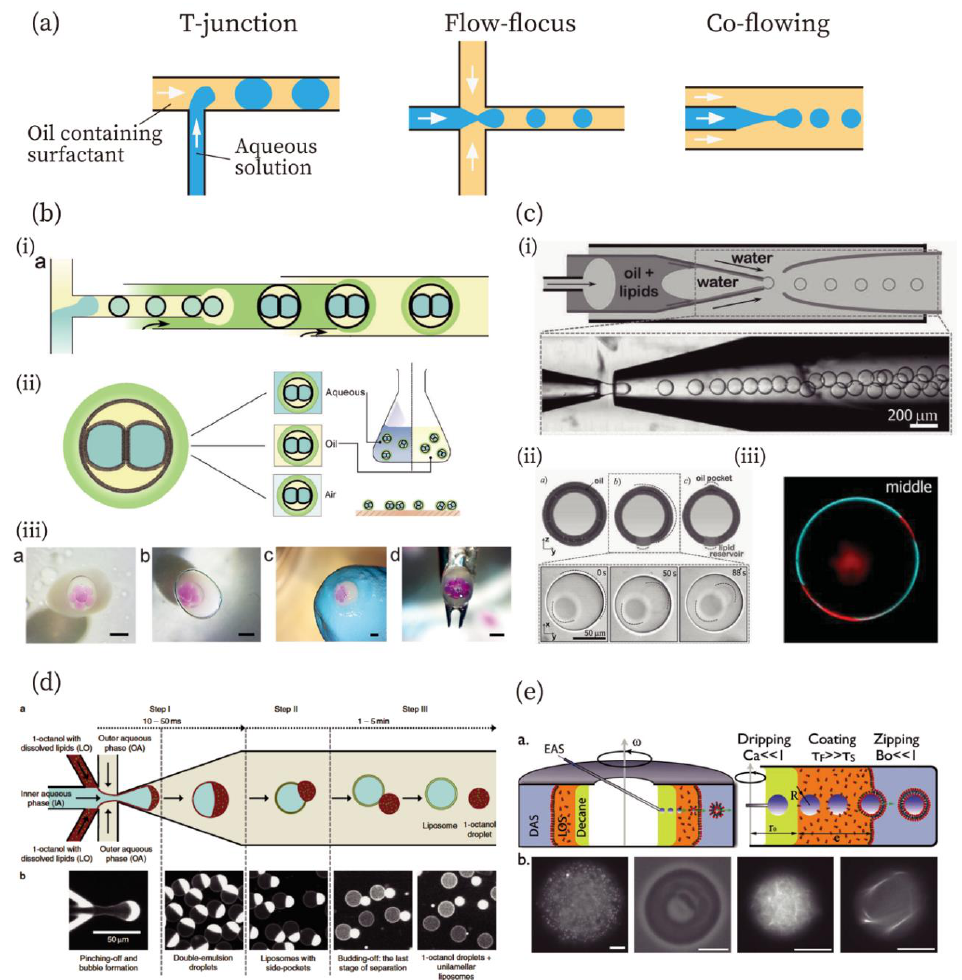
Figure 1. Methods for the production of compartments for artificial cells. ( a ) Typical design of flow channels for the fabrication of W/O emulsions: T-junction, flow-focusing, and co-flowing methods from left to right. ( b ) Droplet interface bilayers (DIBs) from the contact of two W/O emulsions in the large W/O emulsion covered with a gel-shell [43]. (i) Illustration of microfluidic fabrication of gel-encapsulated DIBs. (ii) Schematic illustrations of the gel-encapsulated DIBs in an aqueous, an oil, and an air phase. (iii) Gel-encapsulated DIBs in aqueous, oil, and air phase and manipulated using a tweezer. Scale bars: 1 mm. Reproduced with permission from [43]. ( c ) Fabrication of giant unilamellar vesicles (GUVs) with an ultrathin oil shell using the double emulsion method [49]. (i) An illustration and image for the fabrication of double emulsions with an ultrathin shell. (ii) Illustrations and microscopic images of GUVs with ultrathin shells. (iii) Phase separation of the GUV prepared by this method. Red and cyan colors indicate liquid-disordered and liquid-ordered phases, respectively. Reproduced with permission from [49]. ( d ) Fabrication of GUVs by the octanol-assisted method [50]. (cDICE) method for GUV fabrication [52]. Scale bars: 10 µm. Reproduced with permission from [52].